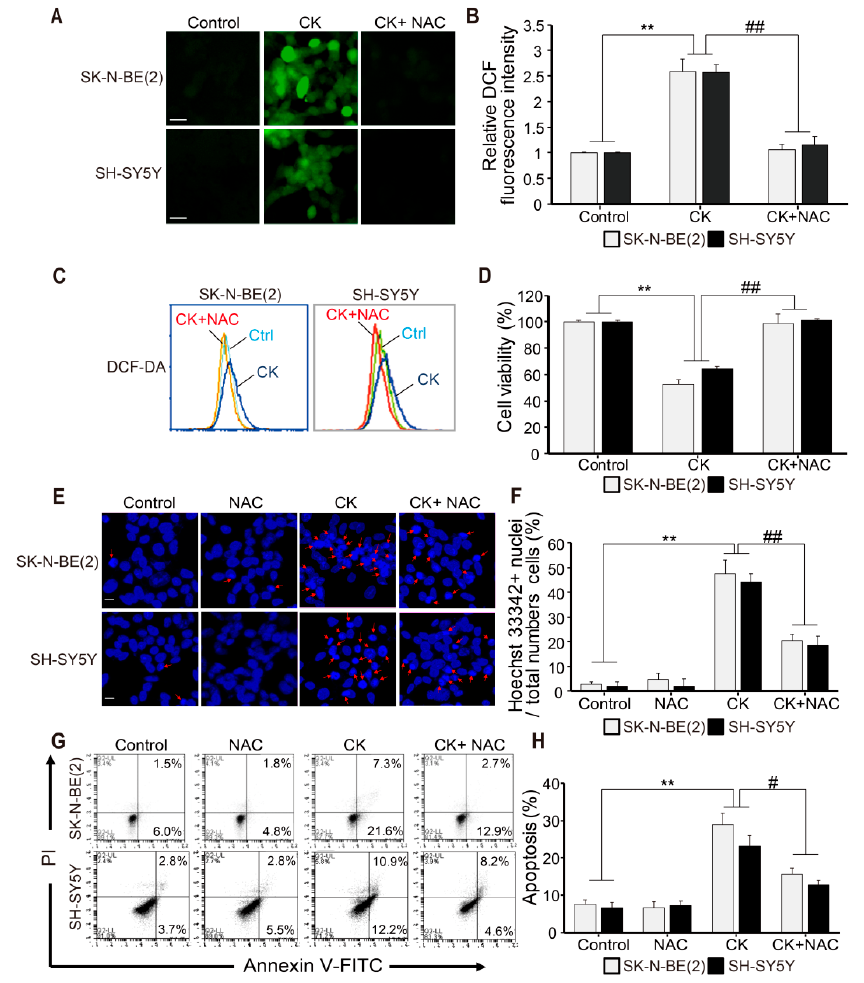
Figure 4. CK-induced apoptosis is associated with reactive oxygen species (ROS) generation in human neuroblastoma cells. ( A – H ) SK-N-BE (2) and SH-SY5Y cells were pretreated with 5 mM NAC for 3